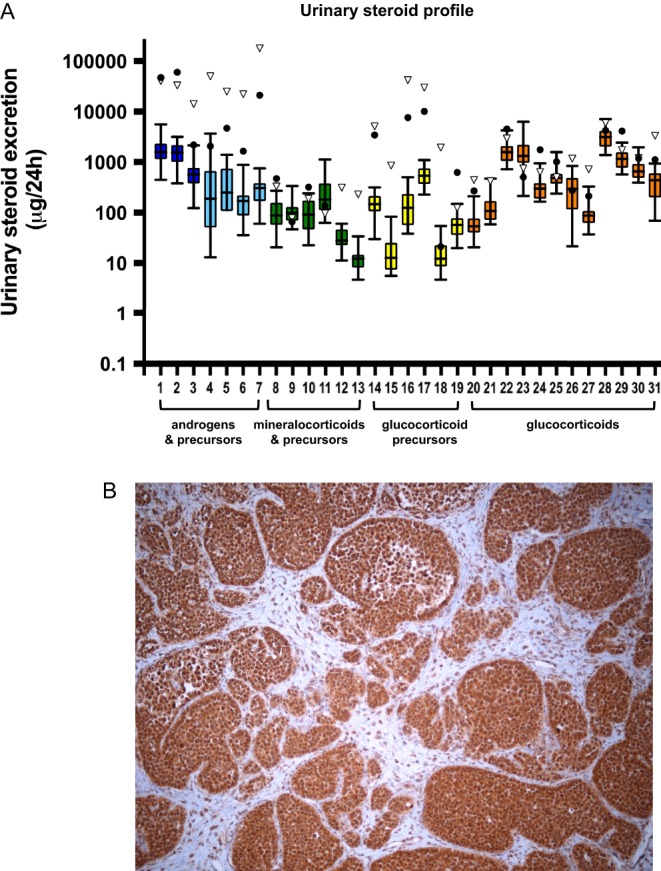
(Panel A) Steroid synthesis in the two patients with metastatic testicular Leydig cell tumor as assessed by mass spectrometry-based 24-h urinary steroid profiling before initiation of mitotane treatment (log scale; closed circles, patient 1; open triangles, patient 2). Box plots represent medians and interquartile ranges from a group of 24 healthy male volunteers (age: 40–60 years); whiskers represent the full range. (Panel B) Immunohistochemical staining for sterol-O-acyltransferase 1 (SOAT1) using formalin-fixed paraffin-embedded tissue from the recurrent tumor of patient 2, demonstrating high (60% of cells) to moderate (30% of cells) expression of SOAT1 in the tumor tissue.